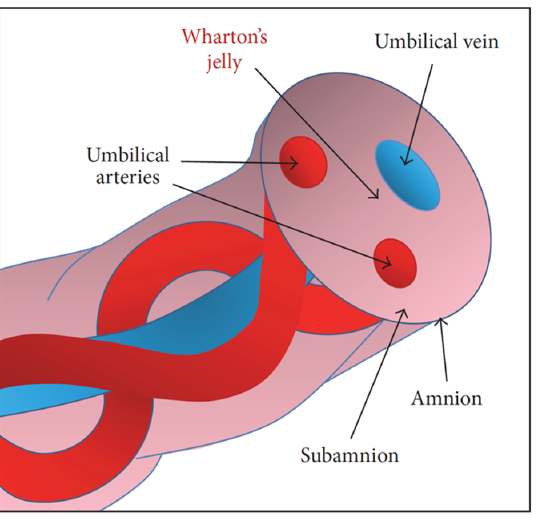
Figure 6. Diagrammatic representation of human umbilical cord. The figure was adapted from Szepesi et al. (2016) [206] .